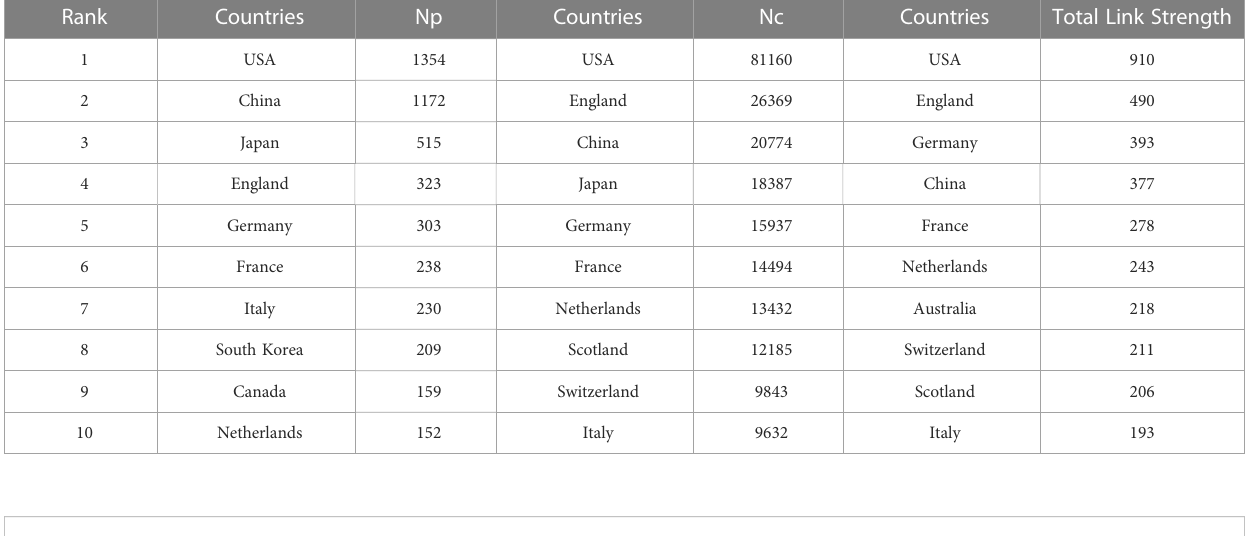
TABLE 1 The top 10 productive countries with publications concerning IL-33.